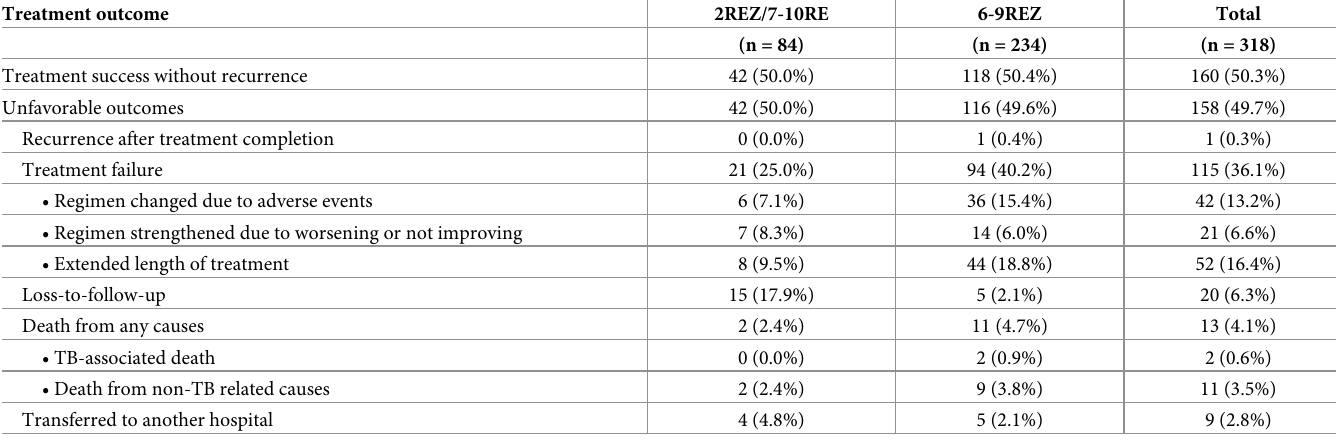
Table 2. Treatment outcomes among 318 enrolled pulmonary tuberculosis patients with isoniazid-resistant rifampicin-susceptible strain.